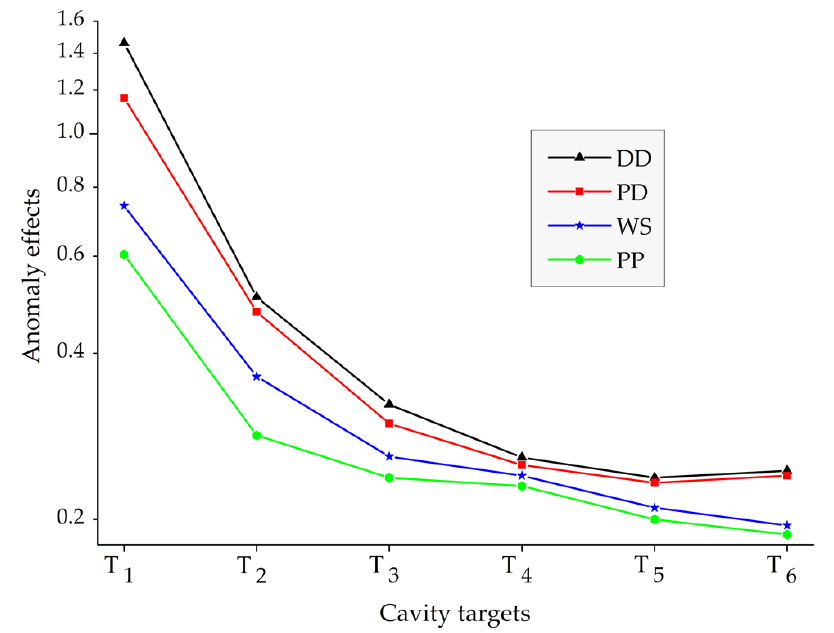
Figure 3. The anomaly effect of the arrays with regard to the air-filled cavity survey depths.